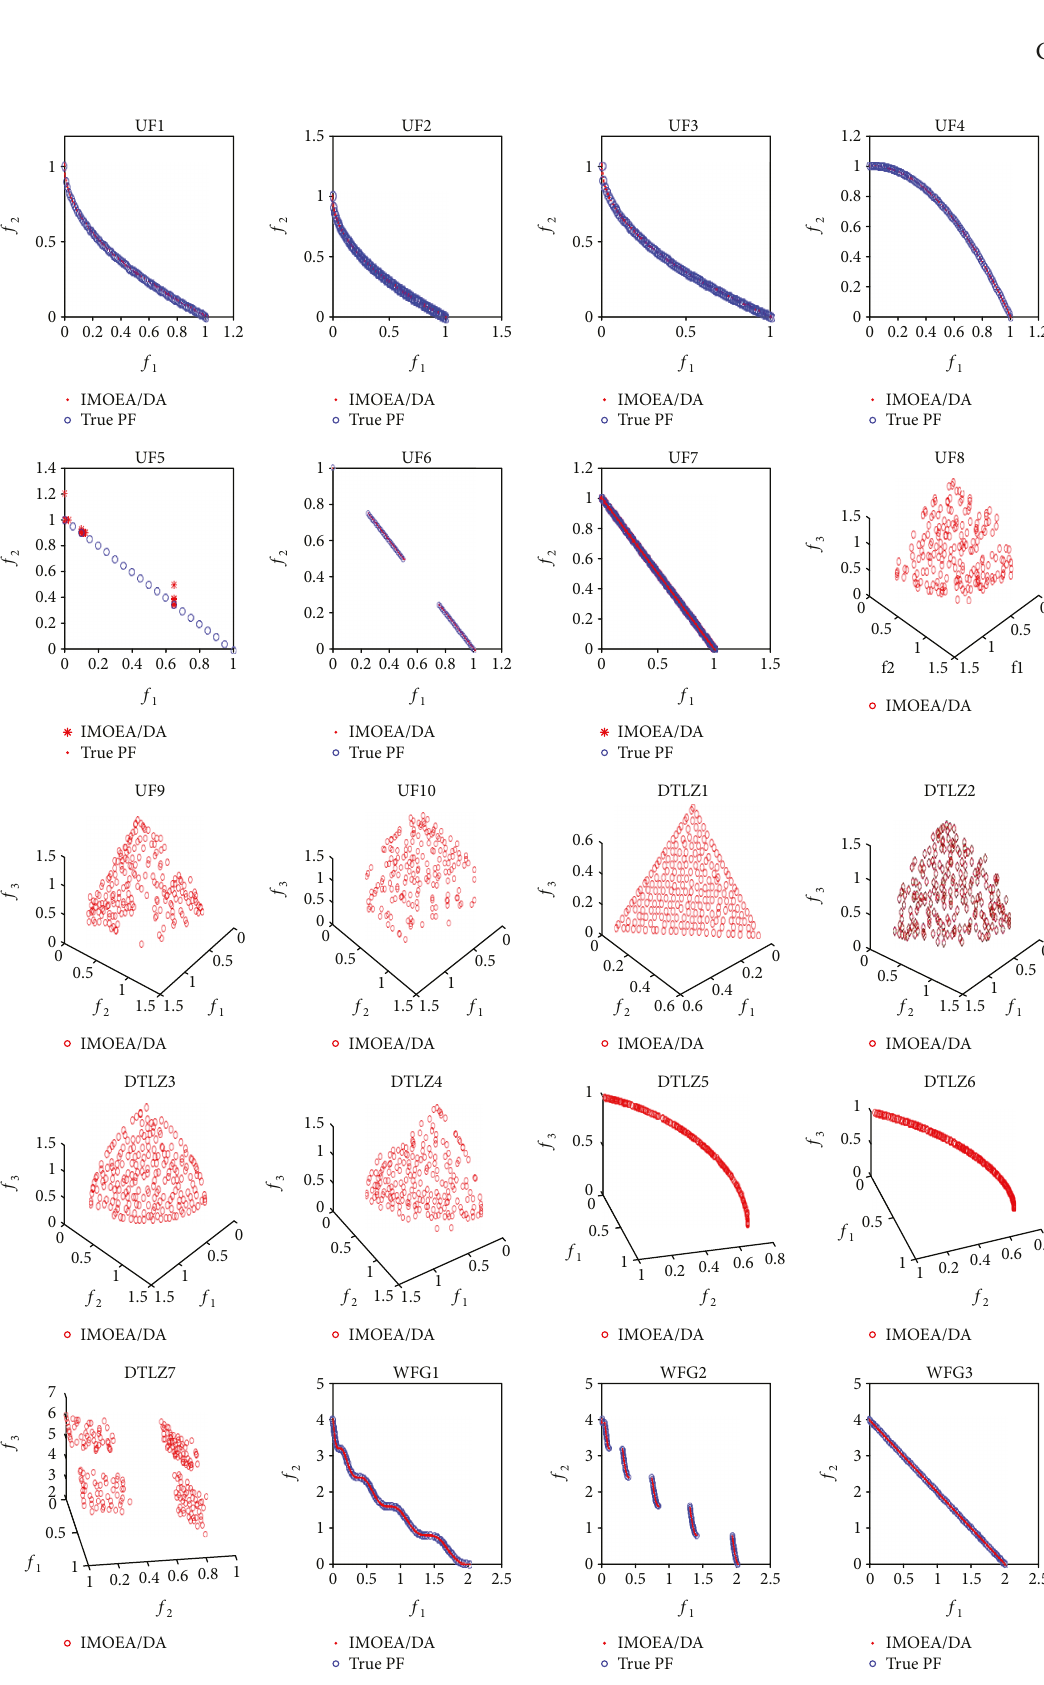
Figure 3: According to the median values of IGD metric, nondominated solutions obtained by IMOEA/DA on ten UF problems, seven DTLZ problems, and WFG1 –